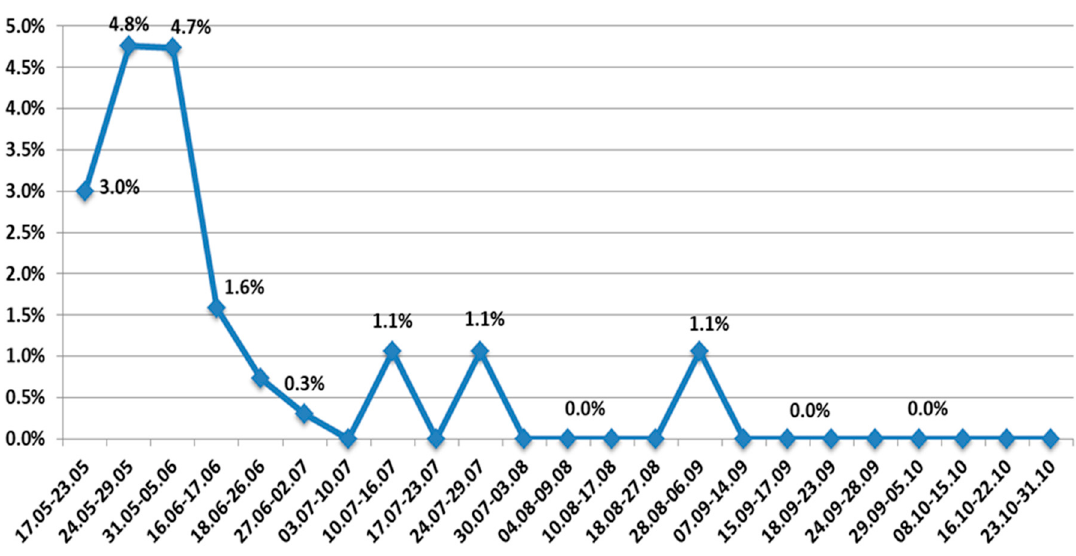
Figure 7. Share of AT.1 among SARS-CoV-2 genetic variants in northwest Russia in